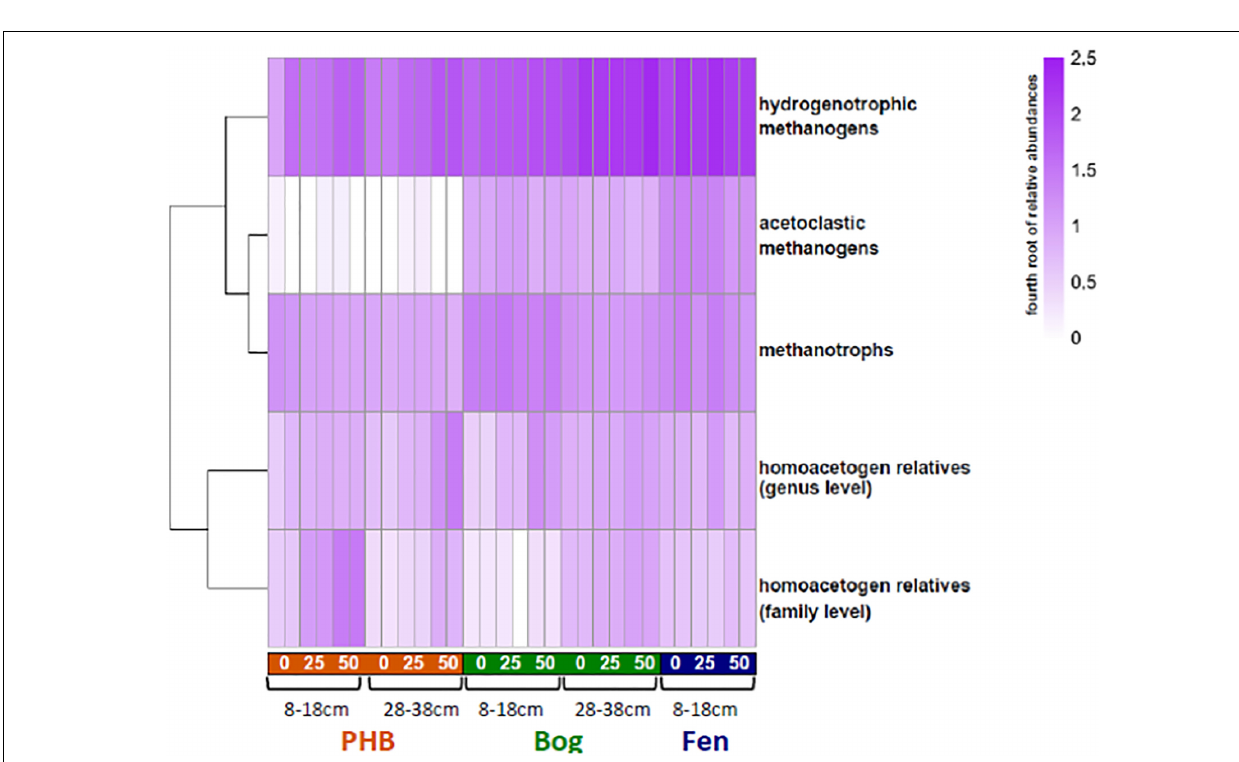
FIGURE 6 | Heat map of relative abundances of microbial functional groups in incubations. For each time point, the two replicates are shown separately. For better visualization across a broad range of abundances for these groups, the color intensity is scaled to the fourth root of the abundances (untransformed relative abundances are provided in Supplementary Table S2